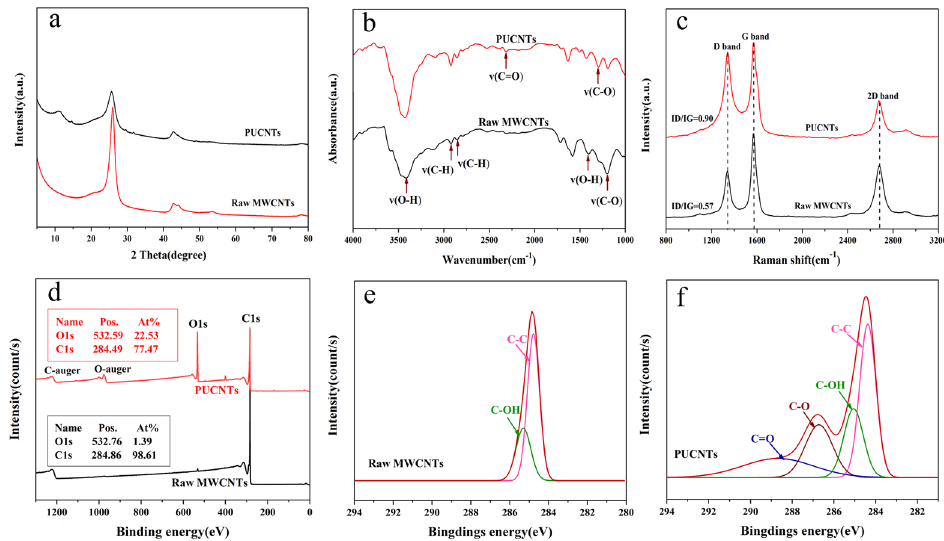
Figure 2. ( a ) XRD patterns of raw MWCNTs and PUCNTs. ( b ) FTIR spectra of raw MWCNTs and PUCNTs. ( c ) Raman spectra of raw MWCNTs and PUCNTs. ( d ) XPS measurement spectra of raw MWCNTs and PUCNTs. ( e ) High-resolution scans of the C1s region of raw MWCNTs and ( f ) PUCNTs.